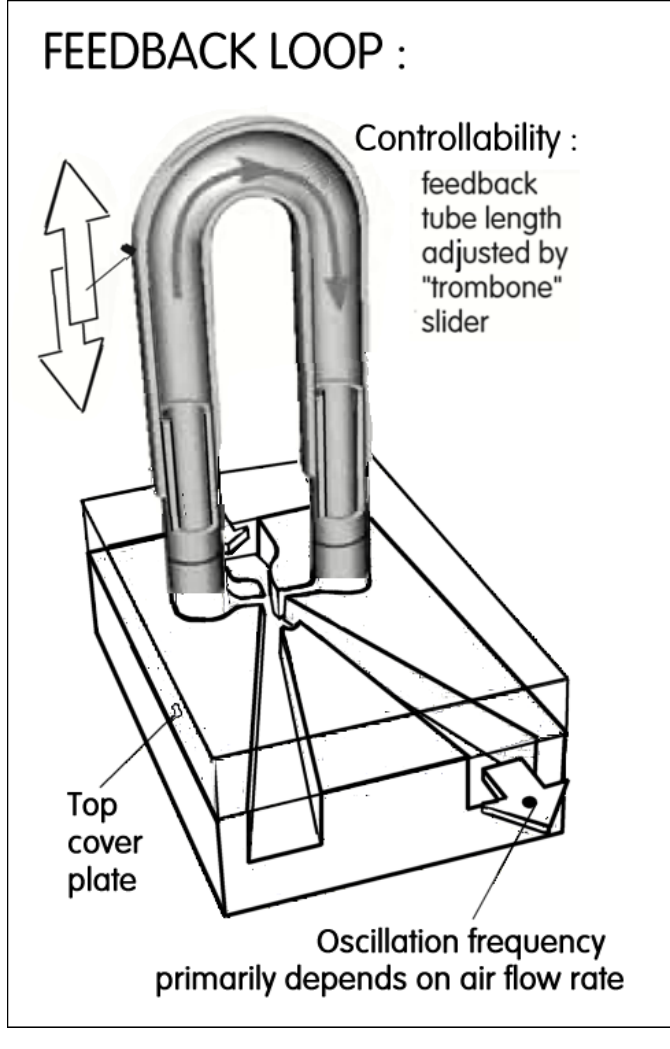
Figure 6. Important property of the T-Z oscillator is its controllability [20]—oscillation frequency adjusting by varying (among other parameters) the feedback loop tube length between the terminals X 1 and X 2 .